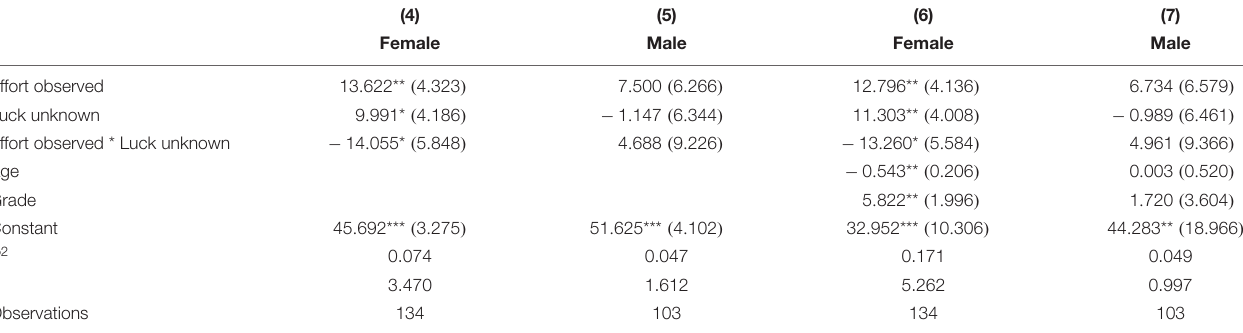
TABLE 7 | Effort, sub-sample ols regression split for male/female